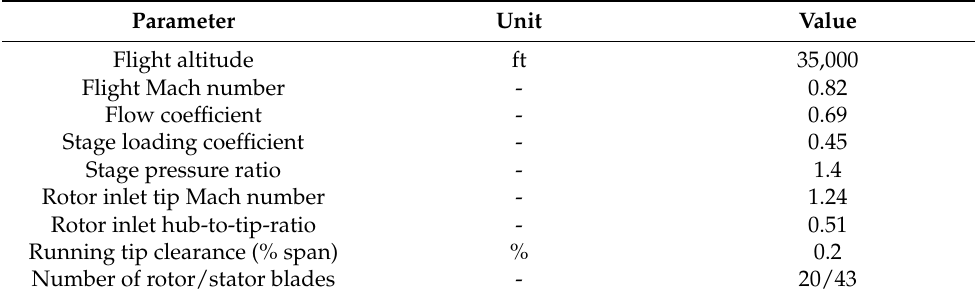
Table 3. Aerodynamic design point parameters of CENTRELINE FF.